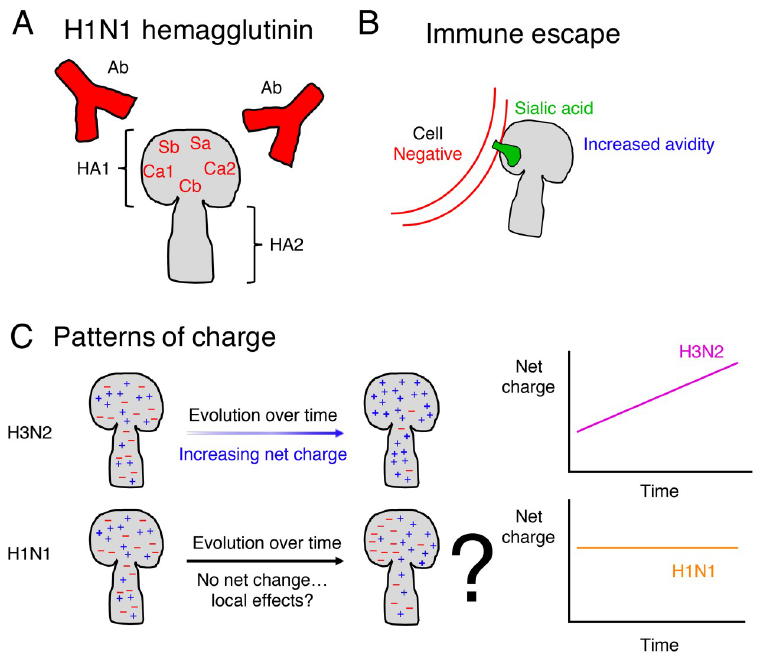
Fig 1. Schematic of host-virus interactions at the hemagglutinin (HA) viral surface protein. ( A ) The structure of the H1N1 HA. The immunodominant HA head (HA1) contains the antigenic sites [8] onto which antibodies bind to neutralize the virus, whereas the HA stalk (HA2) is more conserved. ( B ) Immune escape due to increased avidity mediated by electrostatic charge, according to transmission experiments by Hensley and coauthors [1]. To infect host cells, virions must first successfully enter cells. To accomplish this, the HA protein binds to a cellular receptor, i.e. sialic acid, on the surface of the cell. An increase in charge is posited to increase HA avidity and therefore facilitate HA binding, leading to successful immune escape. ( C ) Patterns of charge over time in natural human sequences. Arinaminpathy and Grenfell [2] showed that the H3 increases over time, but that the H1 is constant. ( Inset ) Schematic of the net charge trends over time for the HAs of H1N1 and H3N2 viruses in natural human sequences.